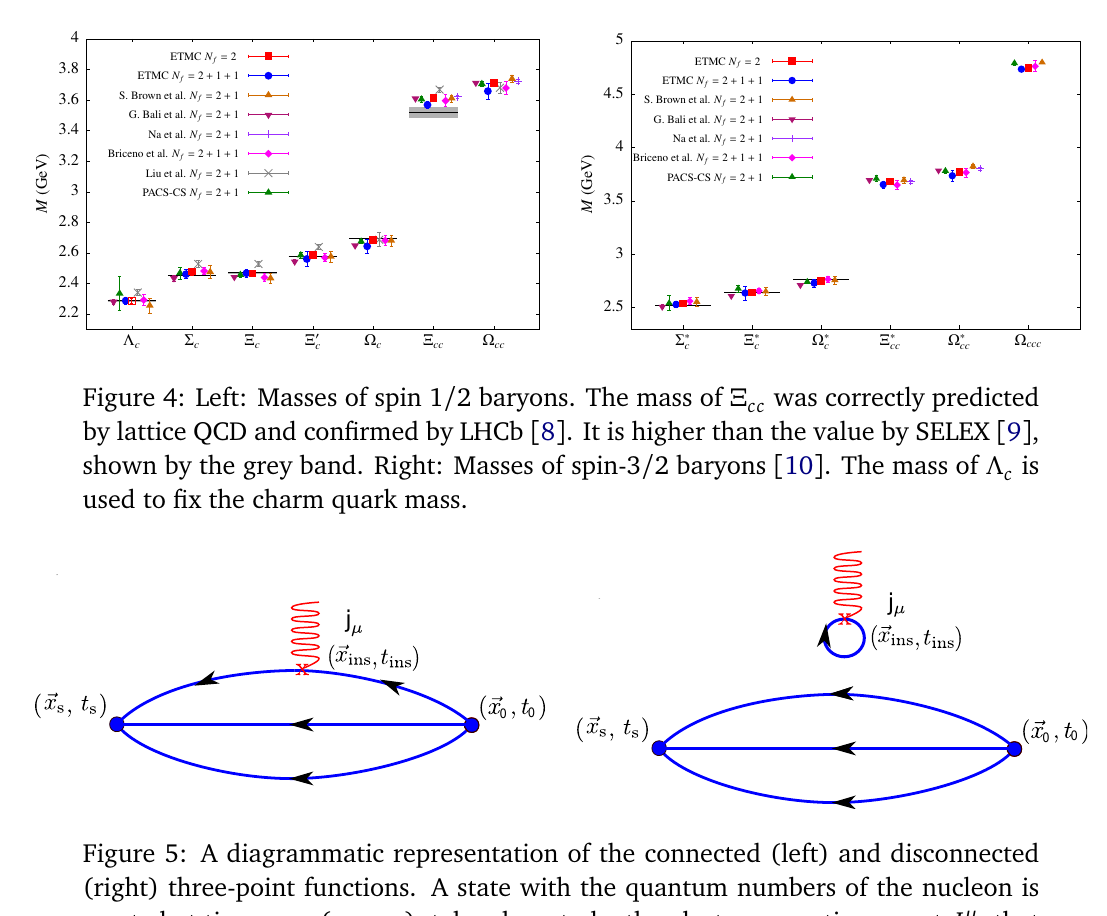
Figure 5: A diagrammatic representation of the connected (left) and disconnected (right) three-point functions. A state with the quantum numbers of the nucleon is created at time zero (source), taken here to be the electromagnetic current J µ , that propagates in Euclidean time and is annihilated at time t (sink). The probe couples s to a quark at time t ins